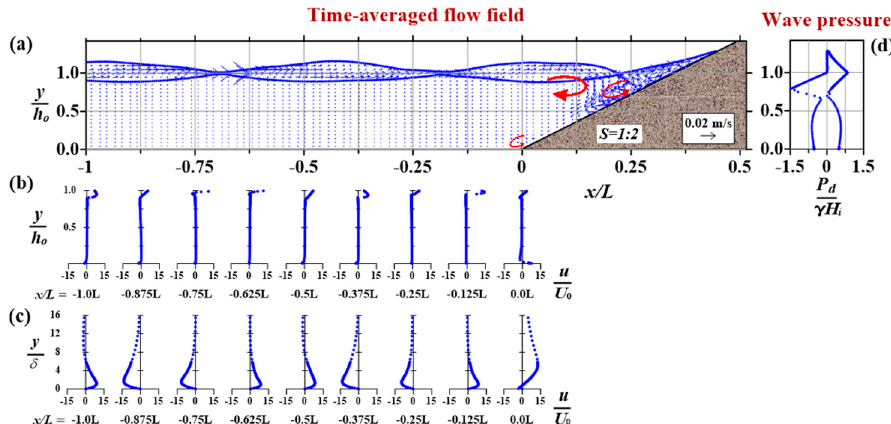
Figure 11. Time − averaged simulation results of the periodic incident wave ( Ur = 4.7) propagation on a steep seawall with a slope of 1:2. ( a ) The time − averaged flow field; ( b ) the averaged horizontal velocity profile; ( c ) the averaged horizontal velocity profile in the boundary layer; ( d ) the maximum wave pressure on the